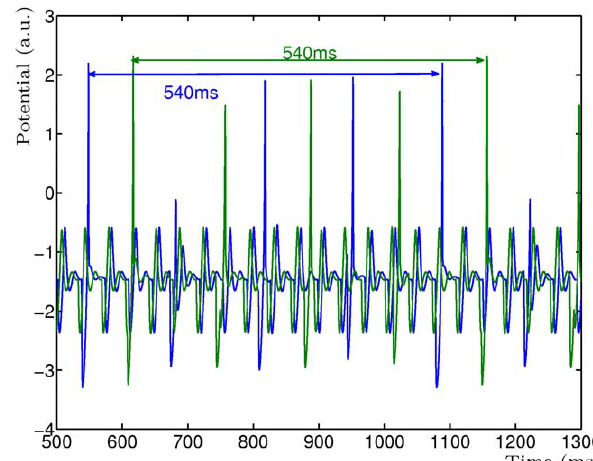
Figure 4. Phase and delay independence of the simple STD model. Two separate simulations of two mutually inhibitory neurons with STD where one simulation has zero phase difference (blue) in input and one simulation has 65 ms phase difference (green) in input. The emergent frequency, as shown by the read-out neuron V , remains the same throughout any phase or delay difference.